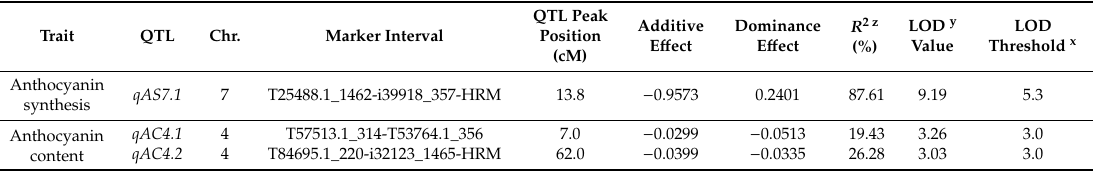
Table 6. Summary of significant quantitative trait loci (QTLs) for anthocyanin synthesis and content identified in the F 2 onion population of SP3B×H6.